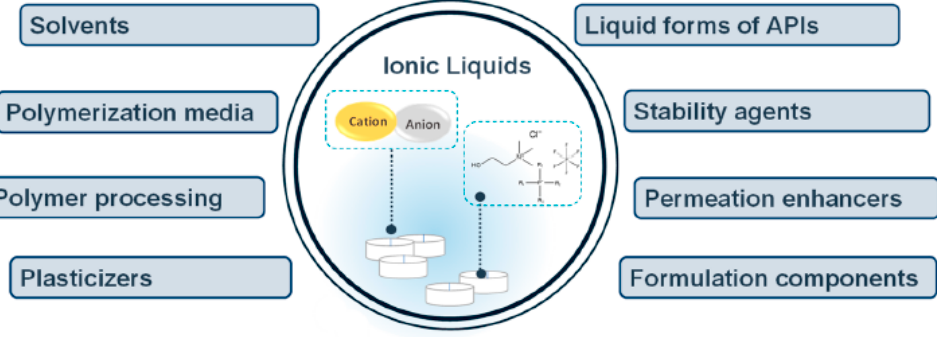
Figure 9. Applications of ILs in drug delivery systems design and development (APIs: active pharmaceuticals ingredients). Reprinted with permission from [118].